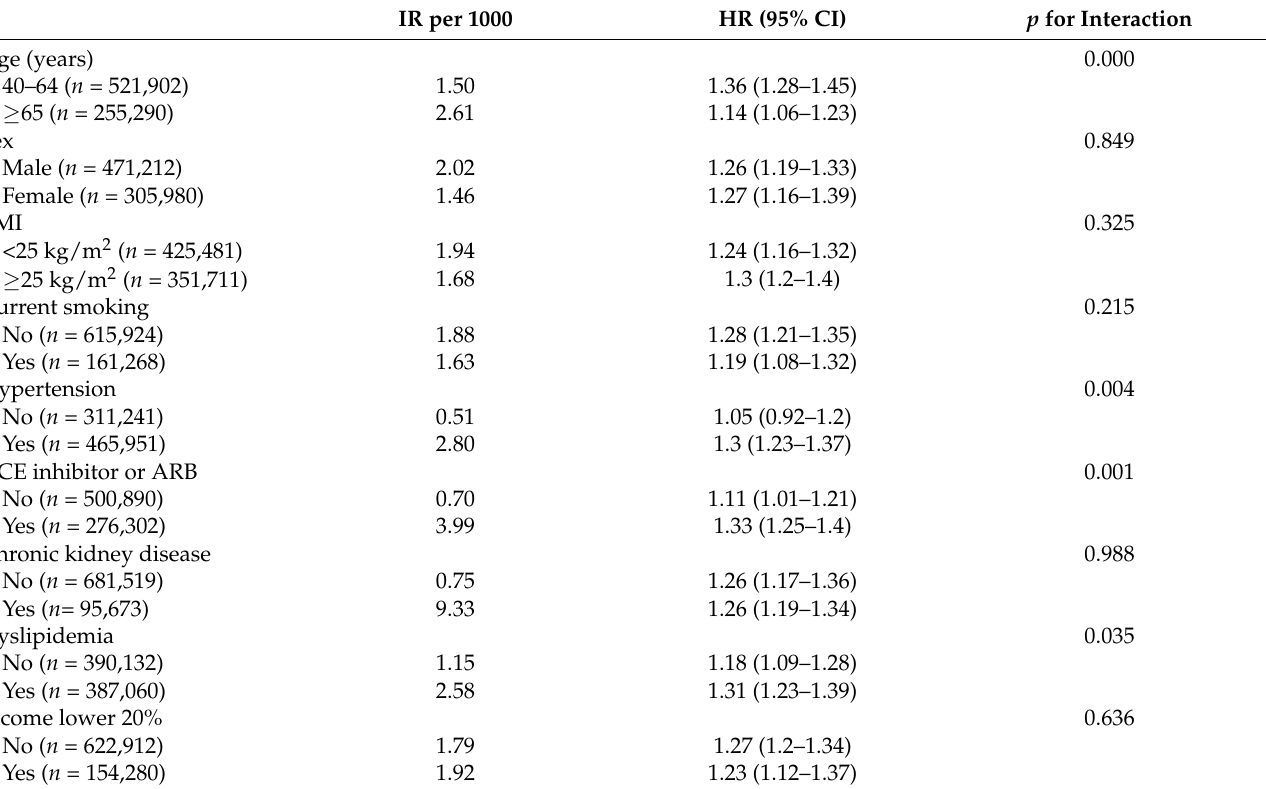
Table 3. Subgroup analysis according to clinically relevant factors in the fasting glucose variability quartile 4 versus quartiles 1–3. IR per 1000 HR (95% CI) p for